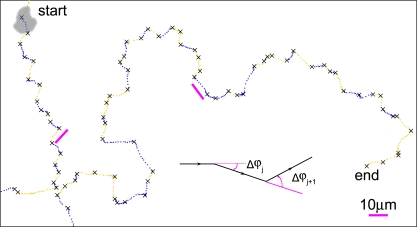
Cells move in a zig-zag manner.Enlarged view of the rectangular box in Fig. 2. The magenta scale-bars are 10 µm. Turns are marked by black crosses. Motion following left turns is blue and motion following right turns is yellow.